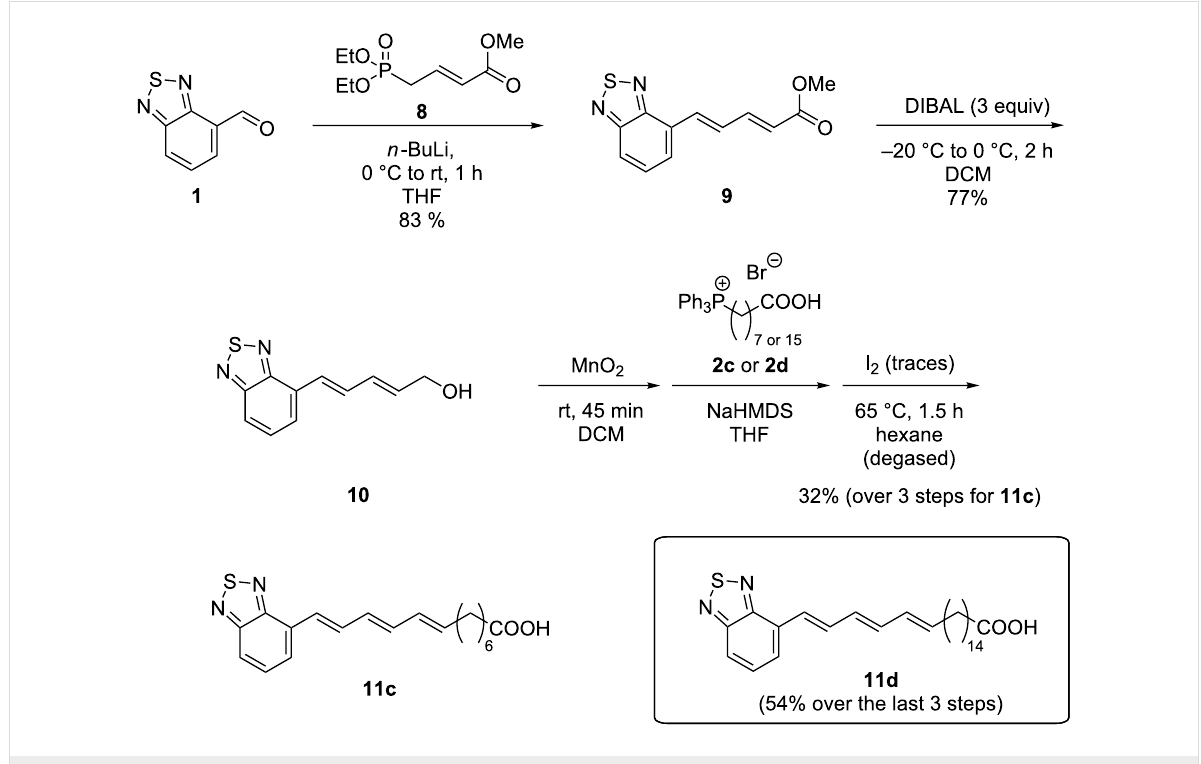
light. By choosing a Wittig salt with a longer alkyl chain the synthesis of the fatty acid 11d with a chain of 21 carbon atoms in addition to the BTD unit was equally feasible.